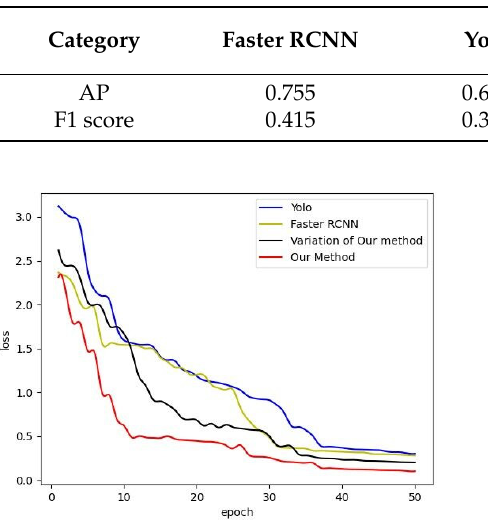
Table 2. AP and F1 score results of the four experiments.